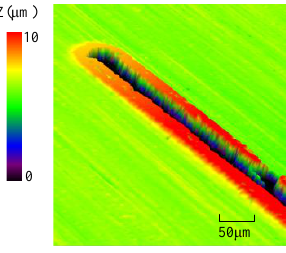
Figure 6. The tiny bulge near the machined region.